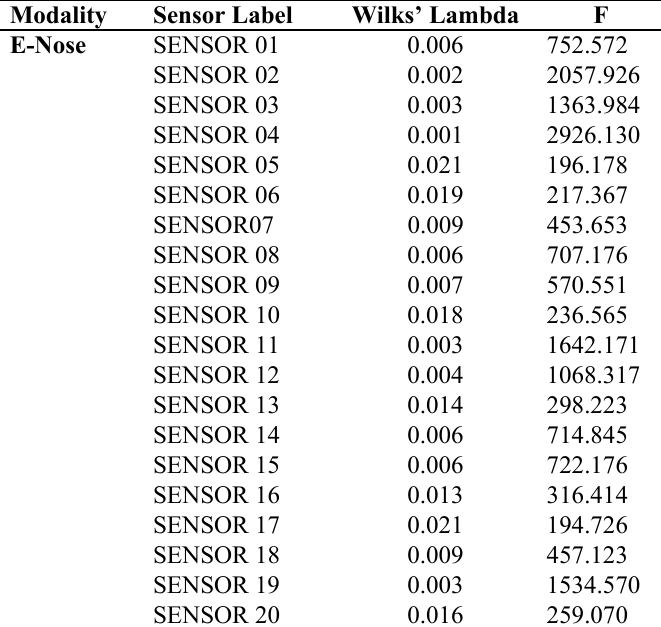
Table 9. Wilks’ Lamda